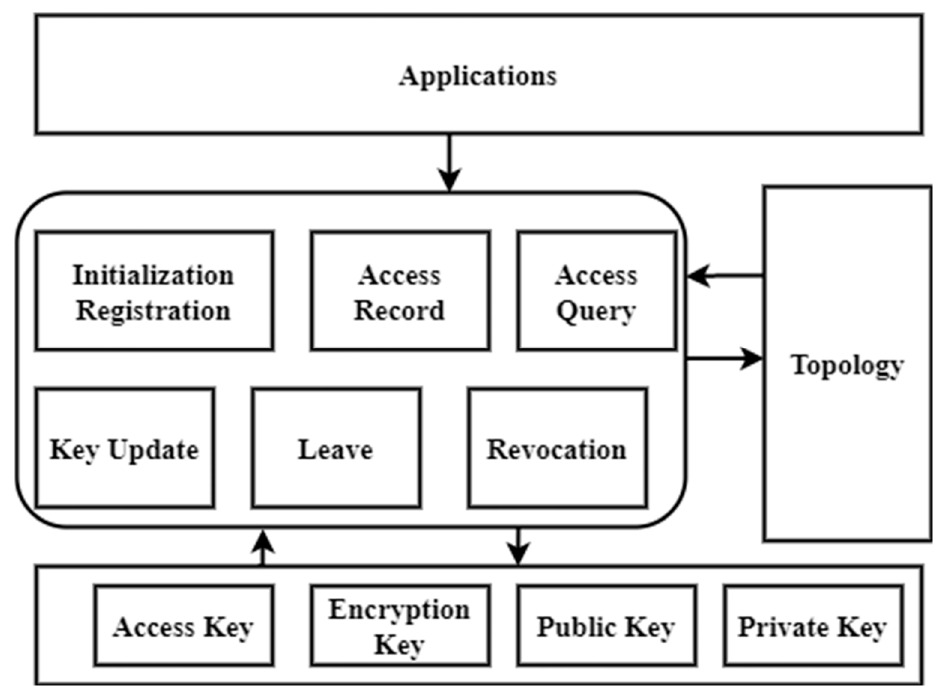
Figure 4. Blockchain-assisted key management.